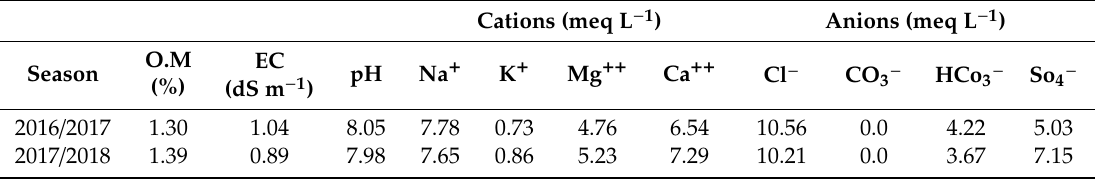
Table 2. Some physicochemical properties of soil used in the two winter growing seasons 2016 / 2017 and 2017 /